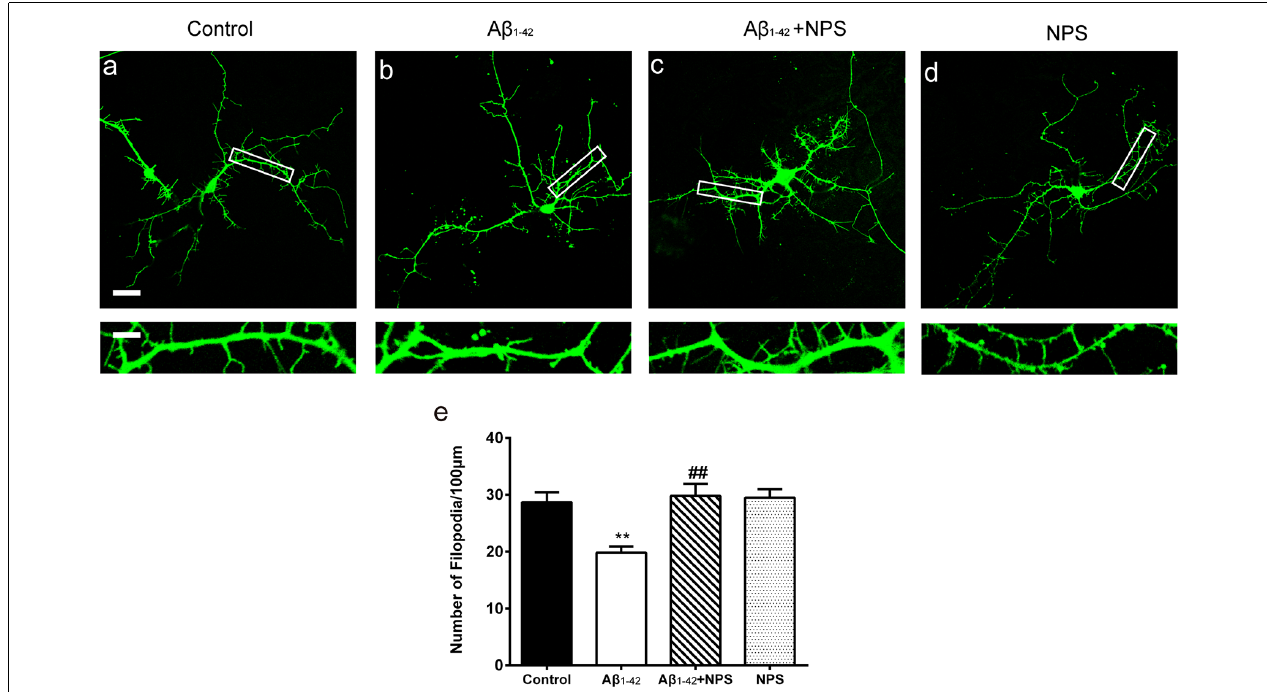
FIGURE 2 | Pharmacological inhibition of CaSR protected hippocampal neurons from soluble A β 1–42 oligomer-induced filopodium loss at day in vitro (DIV) 7. Structural morphology of filopodium of hippocampal neurons was displayed by co-transfection of F-GFP and GFP-actin. Fluorescent figures were displayed with the control group (A) , the 0.5 µ M A β 1–42 group (B) , the 0.5 µ M A β 1–42 + 0.1 µ M NPS 2143 group (C) and the 0.1 µ M NPS 2143 group (D) . Scale bar 20 µ m and 5 µ m. (E) Quantitative comparison of the density of dendritic filopodia of the four groups. ** P < 0.01 vs. control group, ## P < 0.01 vs. A β 1–42 oligomer-treated group. Values represent mean ± SEM, n = 21–25 neurons from three independent primary cell culture